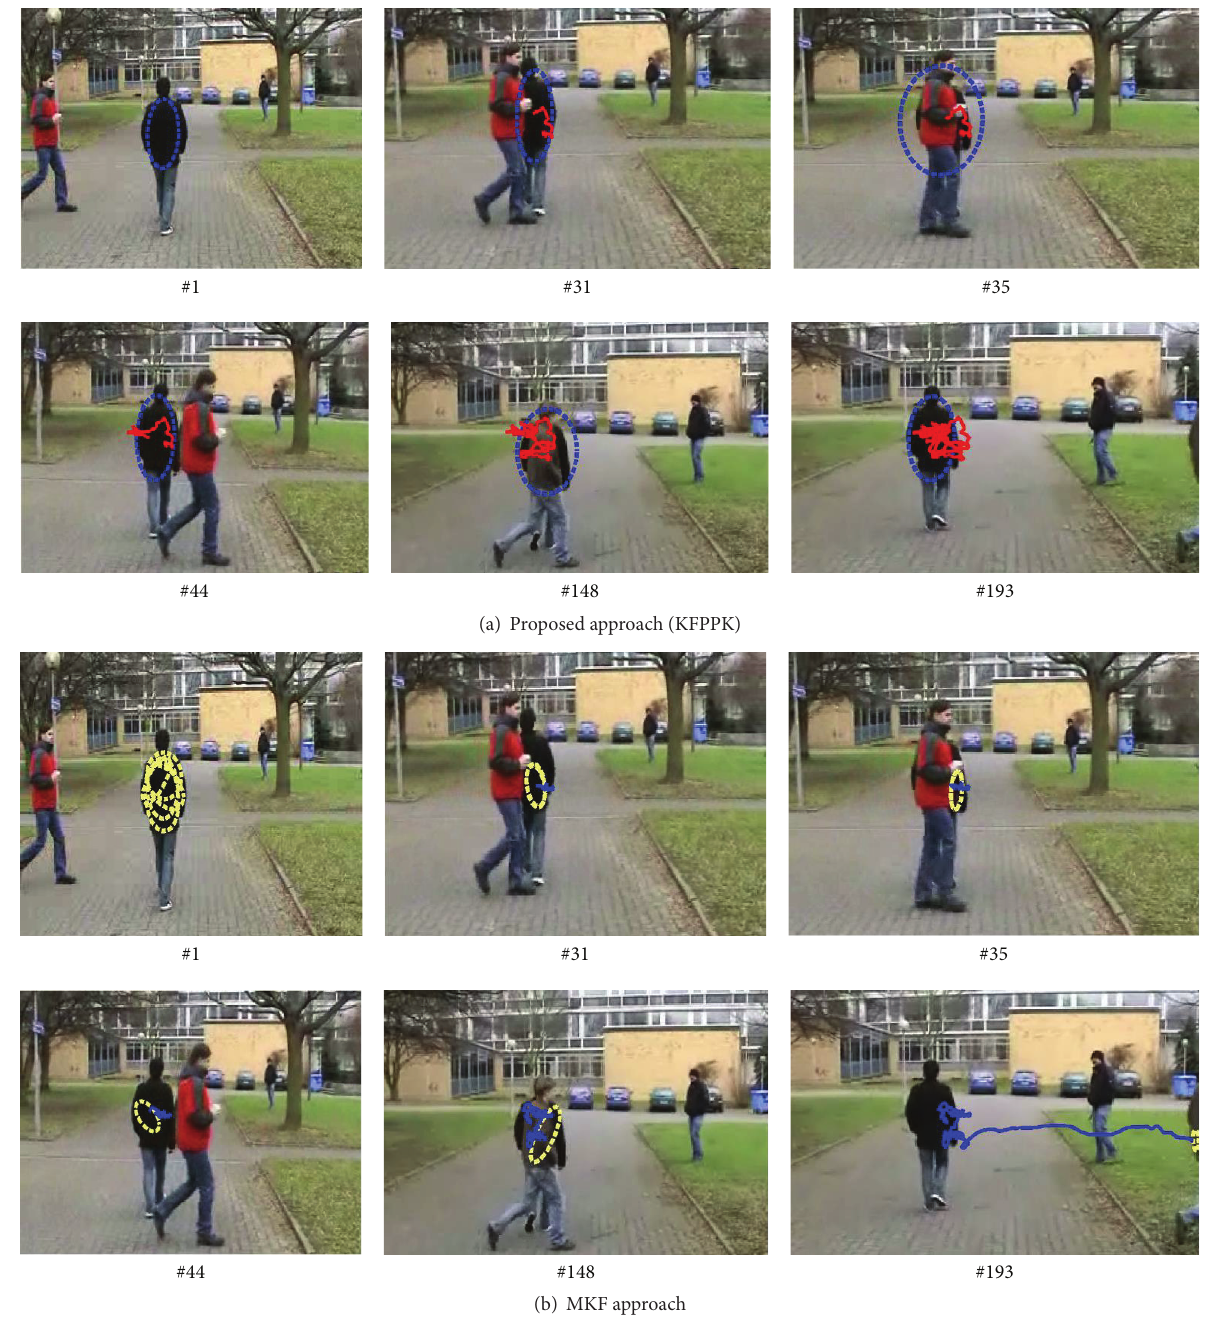
Figure 4: Tracking results of the occlusion sequence by different tracking algorithms. Frames 1, 31, 35, 44, 148, and 193 are displayed.